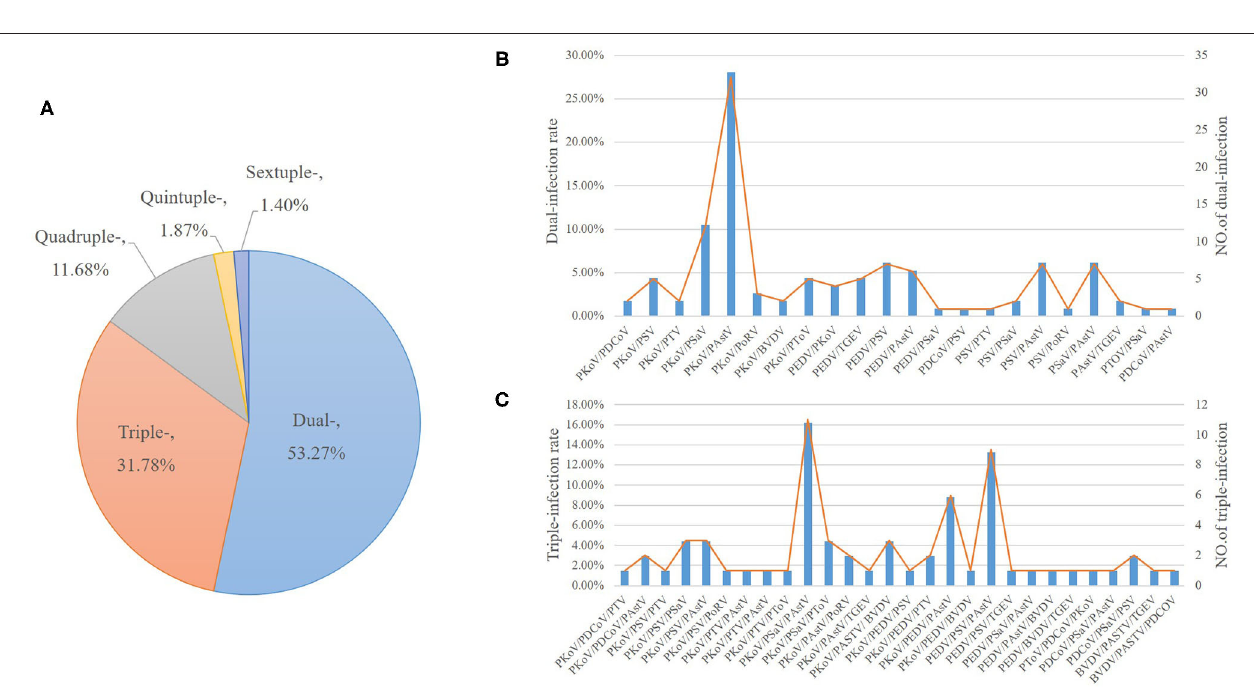
FIGURE 3 | The positive percent of different enteric viruses from 2015 to 2018 in Shanghai. A total of 753 porcine stool specimens from 5 districts in Shanghai were detected by multiplex RT-PCR method.